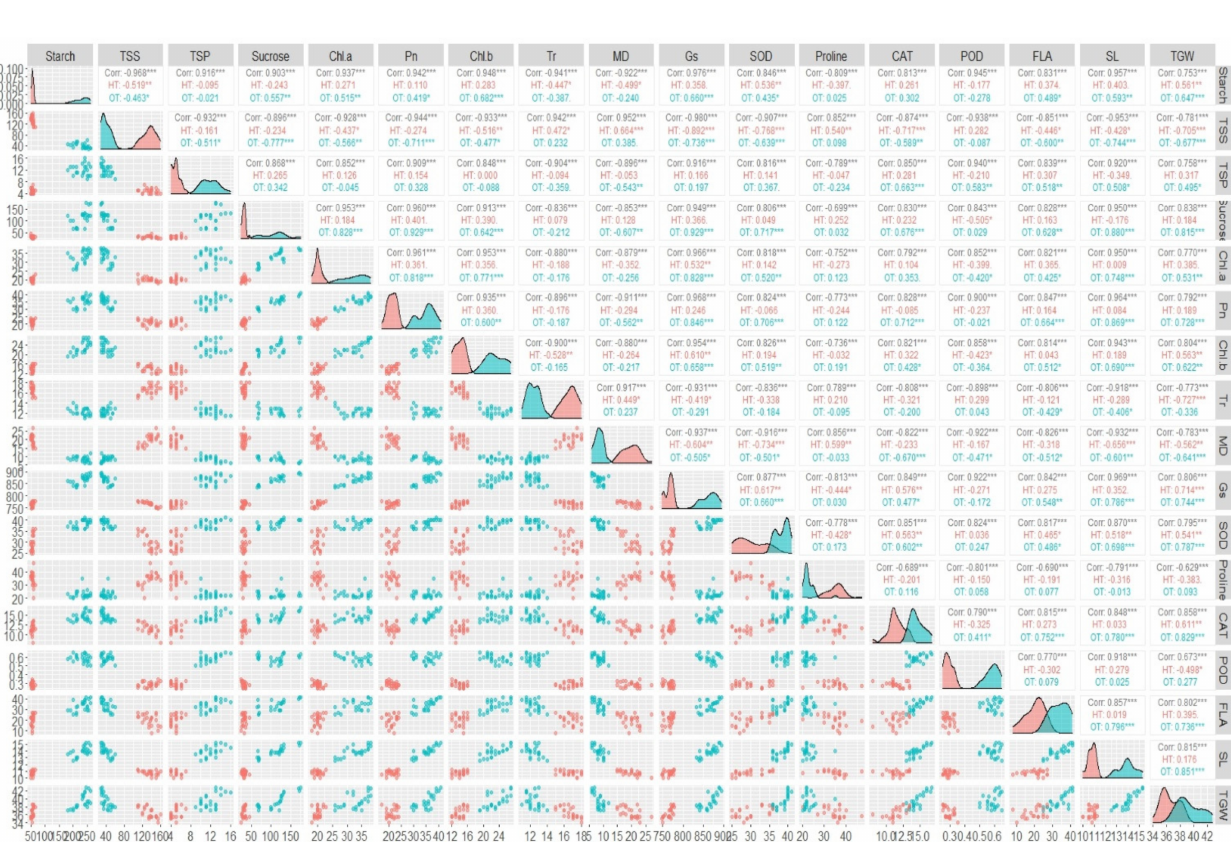
Figure 6. Significance of correlation among osmolytes, physiological parameters, antioxidants and agronomic traits at different regimes of temperature. *** = Significant at p ≤ 0.001; ** = Significant at p ≤ 0.01; * = Significant at p ≤ 0.05. TSS, total soluble sugar; TSP, total soluble proteins; Gs, stomatal conductance; Tr, transpiration rate; MD, membrane damage; Pn, photosynthesis rate; SOD, superoxide dismutase; CAT, catalase; POD, peroxidase; PH, FLA, flag leaf area; SL, spike length; TGW, thousand grain